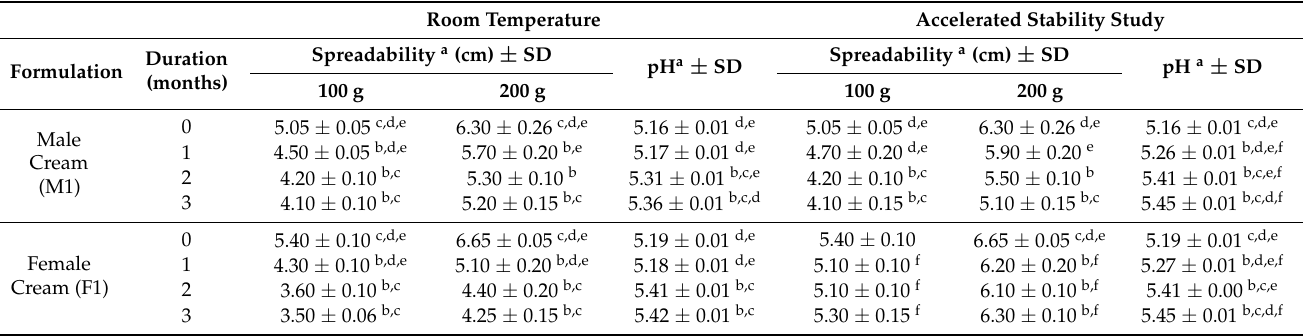
Table 4. Spreadability and pH of creams at room temperature and accelerated stability